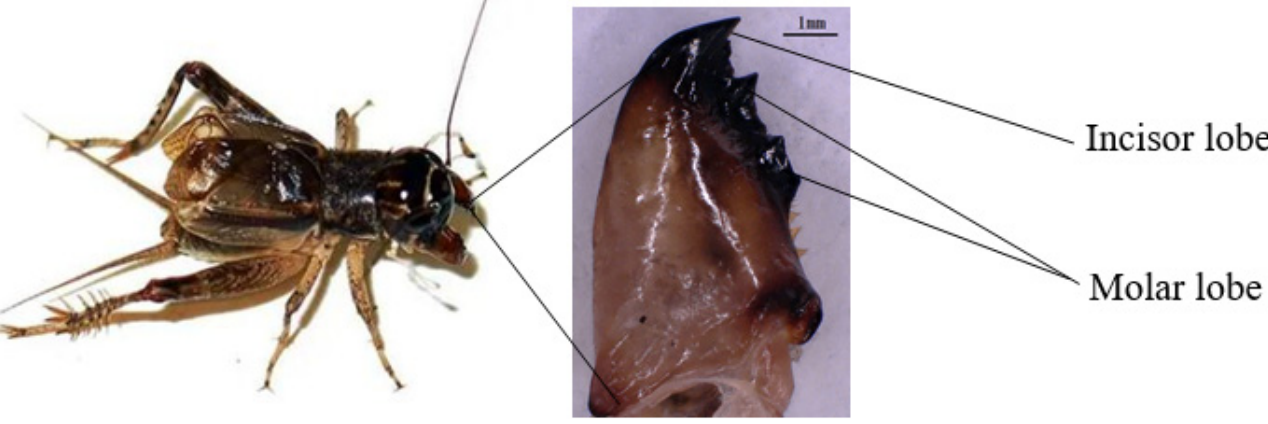
Figure 1. Arc-shaped tooth of cricket mouth part.